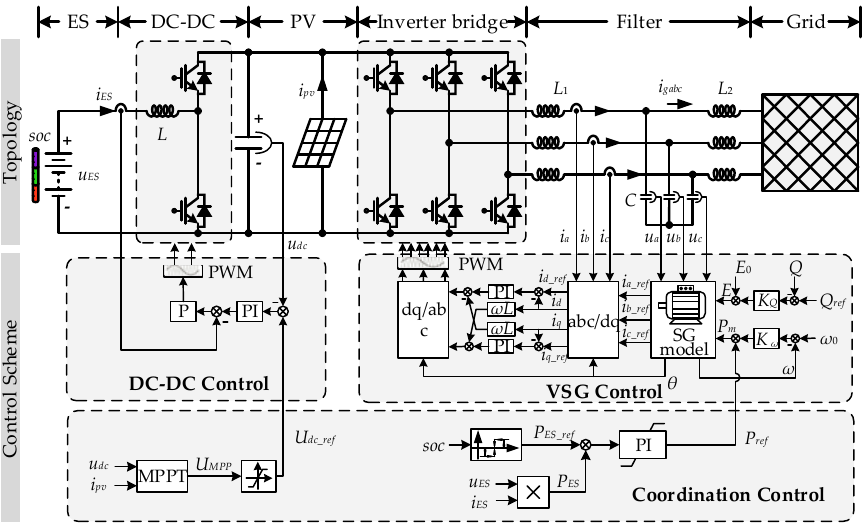
Figure 1. Topology and control scheme of the grid-supporting PV system.